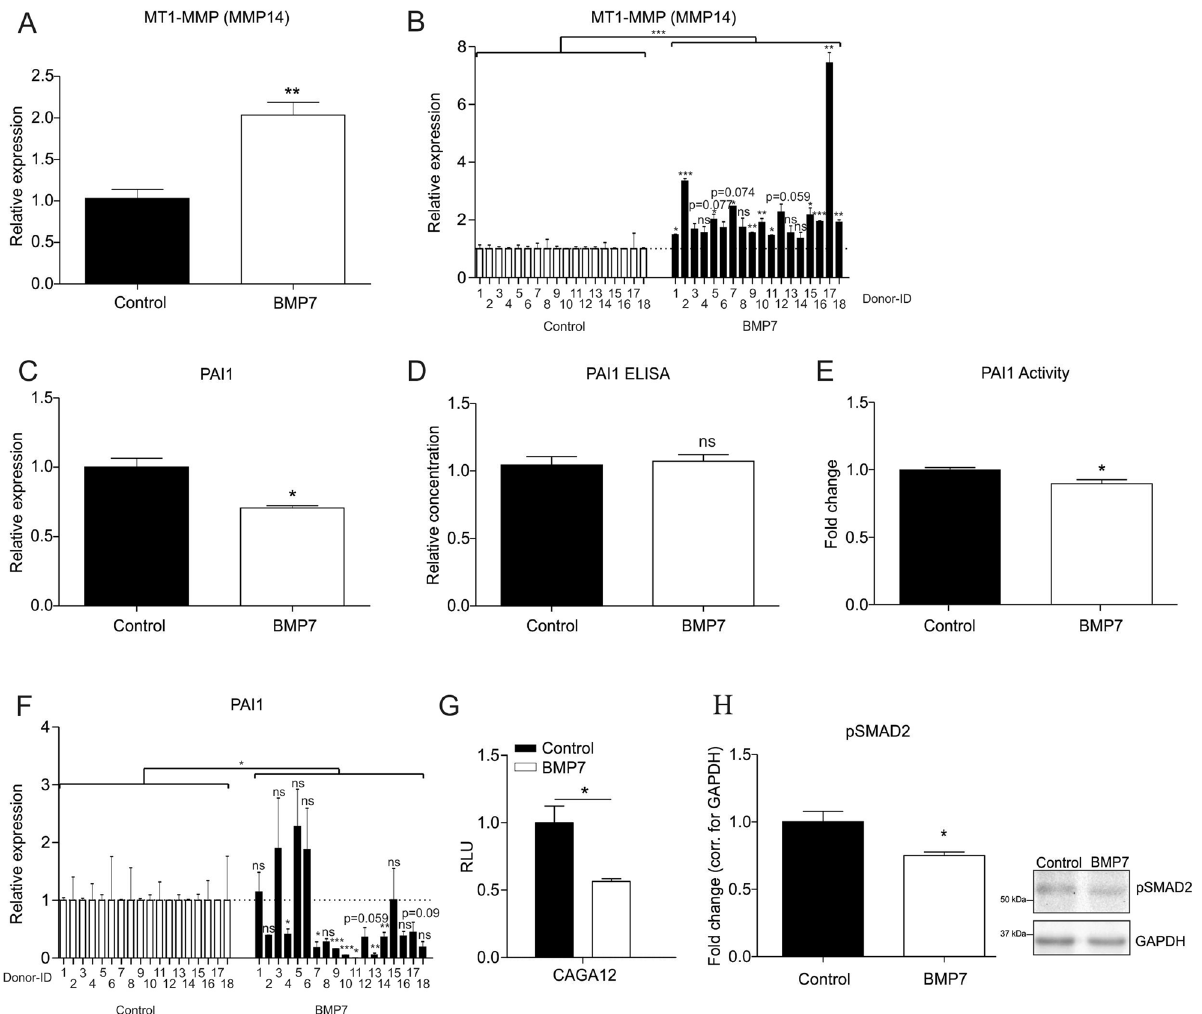
Figure 3. BMP7 impacts PAI1 expression and activity. ( A ) SW1353 cells (biological triplicates) were exposed to 1 nM BMP7 for 24 h and MT1-MMP (MMP14) mRNA expression was determined using RT-qPCR analysis. Data were normalized to cyclophillin expression and set relative to control conditions. ( B ) OA-HACs (n = 18) were exposed to 1 nM BMP7 for 1 day after which MT1-MMP (MMP14) mRNA expression was measured by RT-qPCR. Data were corrected for cyclophillin and set relative to control conditions per patient . ( C ) SW1353 cells (biological triplicates) were exposed to 1 nM BMP7 for 24 h and PAI1 mRNA expression was determined using RT-qPCR analysis. Data were normalized to cyclophillin expression and set relative to control conditions. ( D / E ) In parallel samples with identical treatment (n = 3) PAI1 protein levels and activity in culture supernatant were measured using a PAI1 ELISA and PAI1 activity assay (relative to control condition). ( F ) OA-HACs (n = 18) were exposed to 1 nM BMP7 for 24 h, after which PAI1 mRNA expression was measured by RT-qPCR. Data were normalized for cyclophillin and set relative to control conditions per patient. ( G ) SMAD3 activity was determined in SW1353 cells (biological triplicates) with a (CAGA) 12 -reporter luciferase assay, following exposure to 1 nM BMP7 for 24 h. Results were normalized for CMV-Gaussia bioluminescence and set relative to control conditions. ( H ) pSMAD2 protein levels were determined by Western Blot in SW1353s (n = 1, technical triplicates) after exposure to 1 nM BMP7 for 24 h. Data were normalized for GAPDH and set relative to control conditions. Statistical significance was determined using Student’s t-tests; ( A – G ; B and F per donor and as a group) 2-tailed unpaired, ( H ) 2-tailed paired. Bars show the mean (± SEM). * P < 0.05, ** P < 0.01, *** P < 0.001 versus control conditions, ns not of PAI1 protein in the culture supernatant were not altered (Fig. 3D), the level of PAI1 activity was significantly decreased due to BMP7 (Fig. 3E). Transcription of PAI1 is dependent on SMAD3 activity on the CAGA boxes in the proximal PAI1 promoter sequence 33 . We therefore investigated whether BMP7 was able to inhibit the activity of the (CAGA) 12 reporter 44 . As expected, the activity of the (CAGA) 12 reporter in SW1353 cells was reduced by BMP7 (Fig. 3G). Additionally, BMP7 was also able to reduce pSMAD2 protein levels (Fig. 3H), demonstrating that SMAD2/3 activity is decreased by BMP7 in these cells.